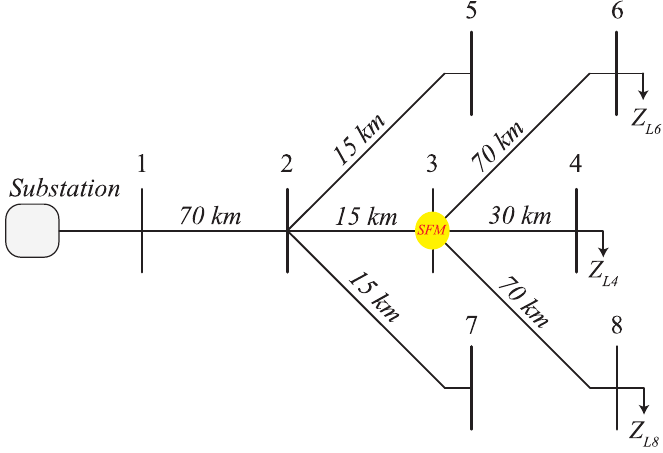
Figure 8. Single line diagram of the laboratory test network. Table 4. Laboratory and simulation result of single-phase to ground